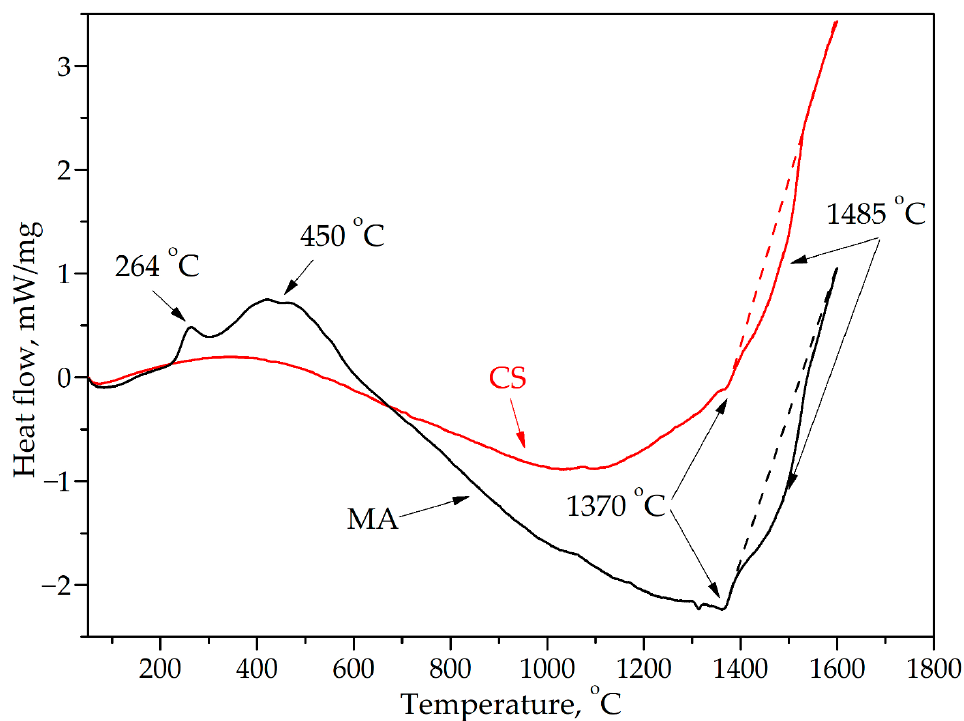
Figure 4. DSC curves for MA and CS powders.